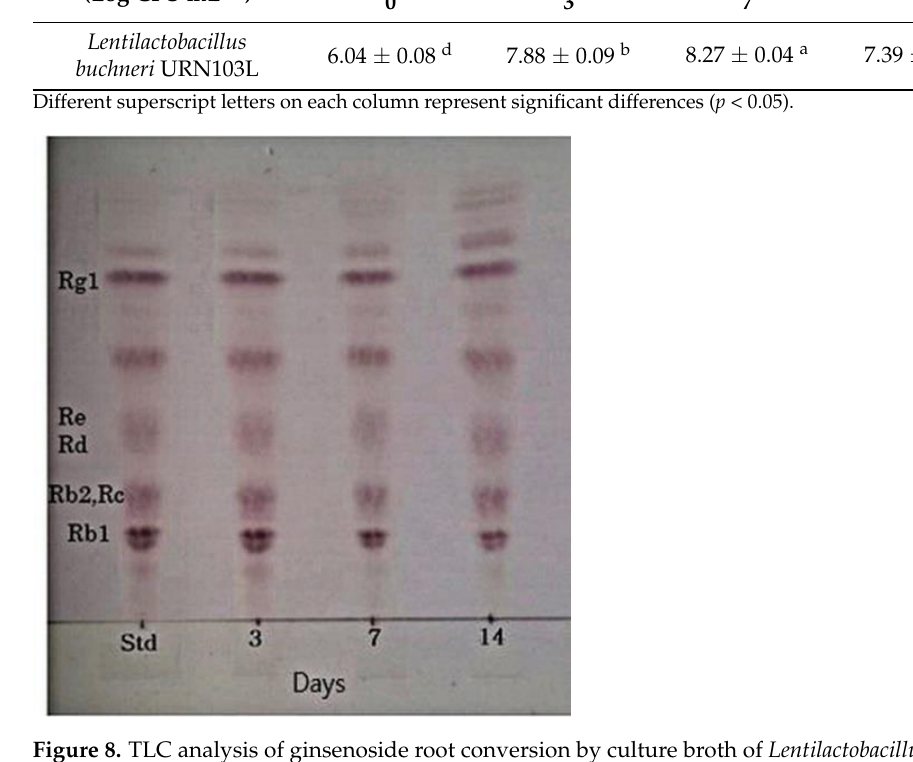
Figure 8. TLC analysis of ginsenoside root conversion by culture broth of Lentilactobacillus buchneri URN103L at optimum condition. Std: standard.